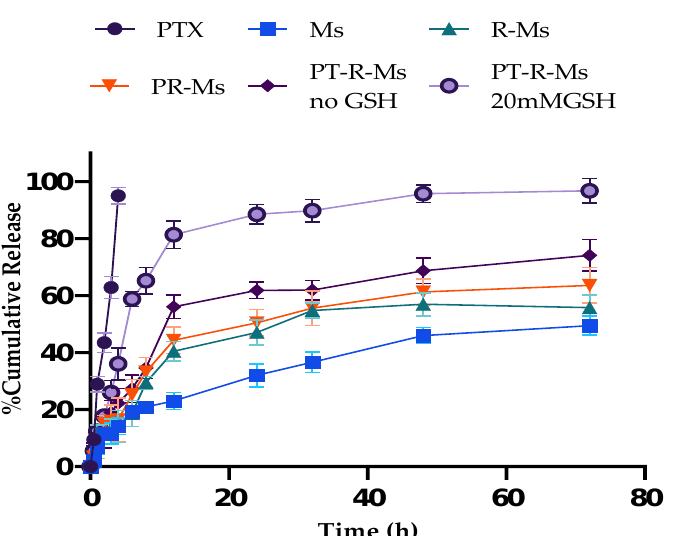
Figure 3. In vitro release of Ms, R-Ms, PR-Ms, and PT-RM (without GSH) and PT-RMs (20 mM GSH). Results are expressed as mean ± SD ( n = 3). Table 2. Drug release kinetic modeling demonstrates the potential drug release mechanisms.